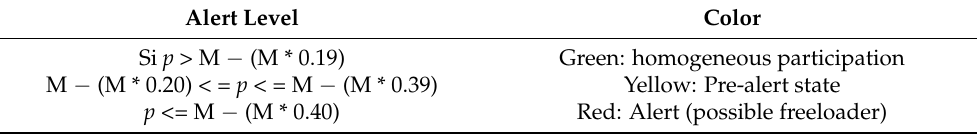
Table 10. Colors that correspond to the level of alert in relation to the number of messages in each